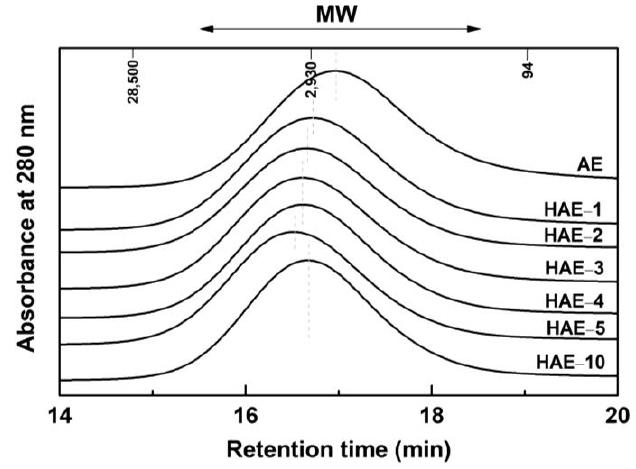
Figure 6. GPC chromatogram of Ac-AE and Ac-HAEs.